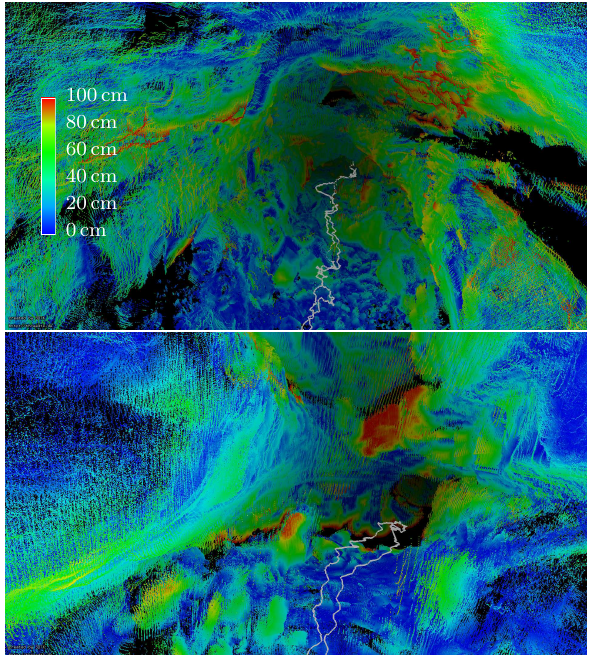
Figure 7. Final point cloud for dataset Trajectory2D, colored by deviation from ground truth. Above: detail from the lavatube near the starting point. Below: detail at the turning point of the trajectory. The gray line resembles the trajectory.